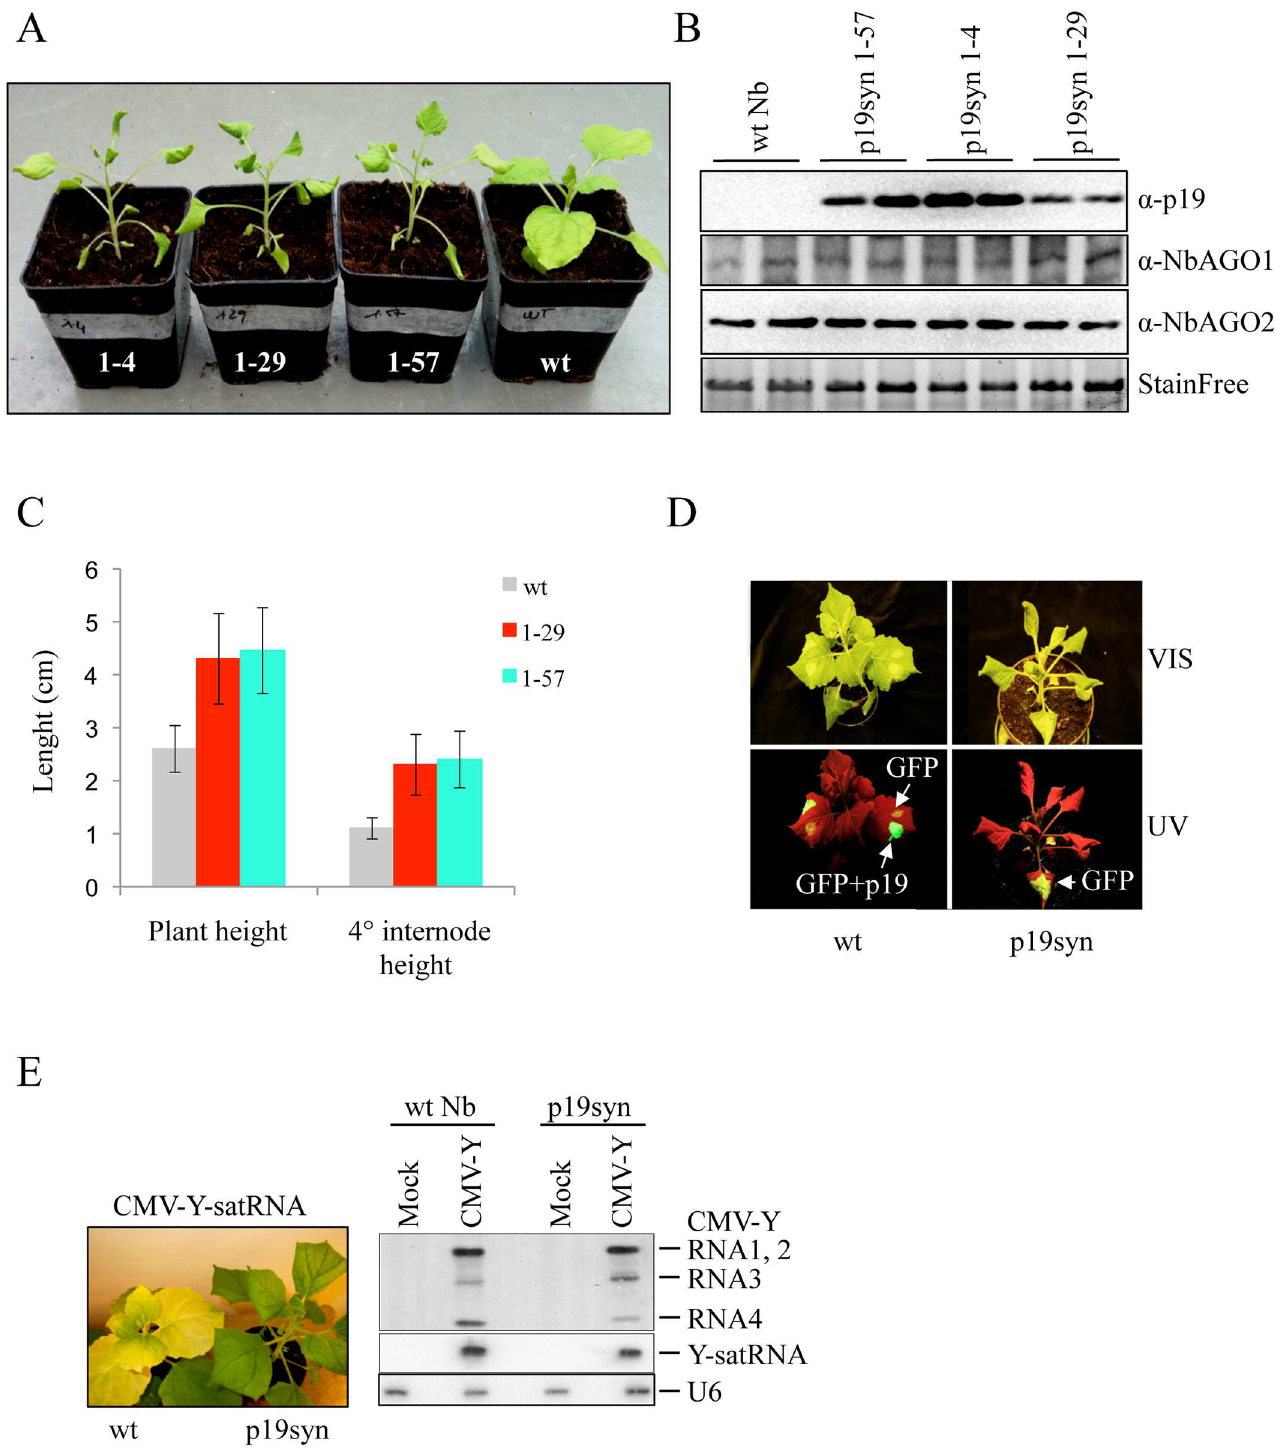
Fig 1. p19 protein expressing transgenic Nicotiana benthamiana (p19syn) plants. (A) Specific developmental phenotype of p19syn plants comparedto wild type plants. Three representative independent transgeniclines are shown alongsidewild-type N . benthamiana plant. (B) Western blot of p19syn transgenicand wild-type plants from lines shown in (A). The presence of p19 transgene does not impact NbAGO1 or NbAGO2 protein levels. Protein loadingis shown below (StainFree). (C) Stem length from cotyledons to the fourth and last leaf insertion in wt and T1 p19syn plants at 8–9 leaf stage (lines:1–29and 1–57) were used to show the elongated internode trait of p19syn plants. Bars: standard deviation. (D) Wild